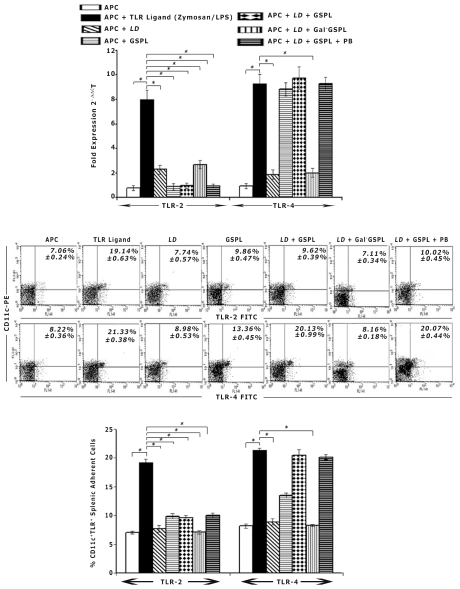
GSPL upregulates TLR4 expression in splenic adherent cells.Splenic adherent cells were infected with LD promastigotes (24 h) at 20∶1 parasite-to-splenic cell ratio followed by treatment with 100 µg/mL of GSPL, β-galactosidase treated GSPL (Gal−GSPL) or GSPL along with 100 ng/mL Polymixin B (GSPL+PB) for 9 h. TLR expressions were also evaluated in unstimulated splenic adherent cells and adherent cells stimulated with GSPL, Zymosan (TLR2) or LPS (TLR4) for 9 h. TLR expression was evaluated by real-time PCR (A) and flow cytometry (B) for individual cover slips. Bar graphs in B show the percent of CD11c+ cells expressing TLR2 or TLR4 in splenic adherent cells. The results are representative of three independent experiments. Error bars represent mean ± SD, n=3. * p<0.0001; paired two-tailed Student's t-test.